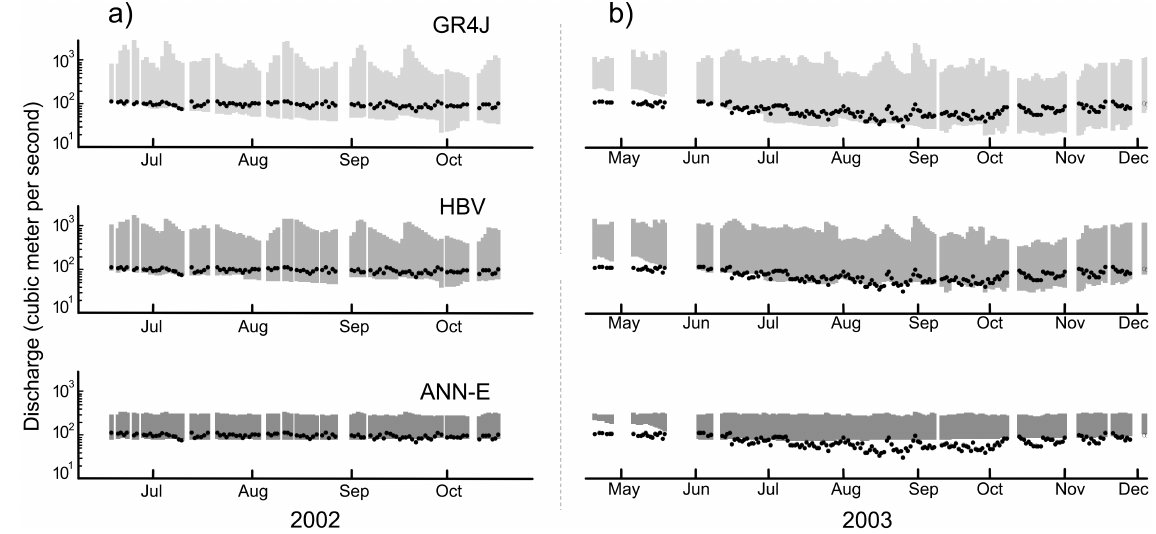
Figure 3. Range (shown as grey shade) of low-flow forecasts in (a) 2002 (the wettest year of the test period with 101 low-flow days) and (b) 2003 (the driest year of the test period with 192 low-flow days) for a lead time of 90 days using ensemble P and PET as input for GR4J, HBV and ANN-E models (case 1 – 2002 and 2003). The gaps in the figures indicate non-low-flow days (i.e.